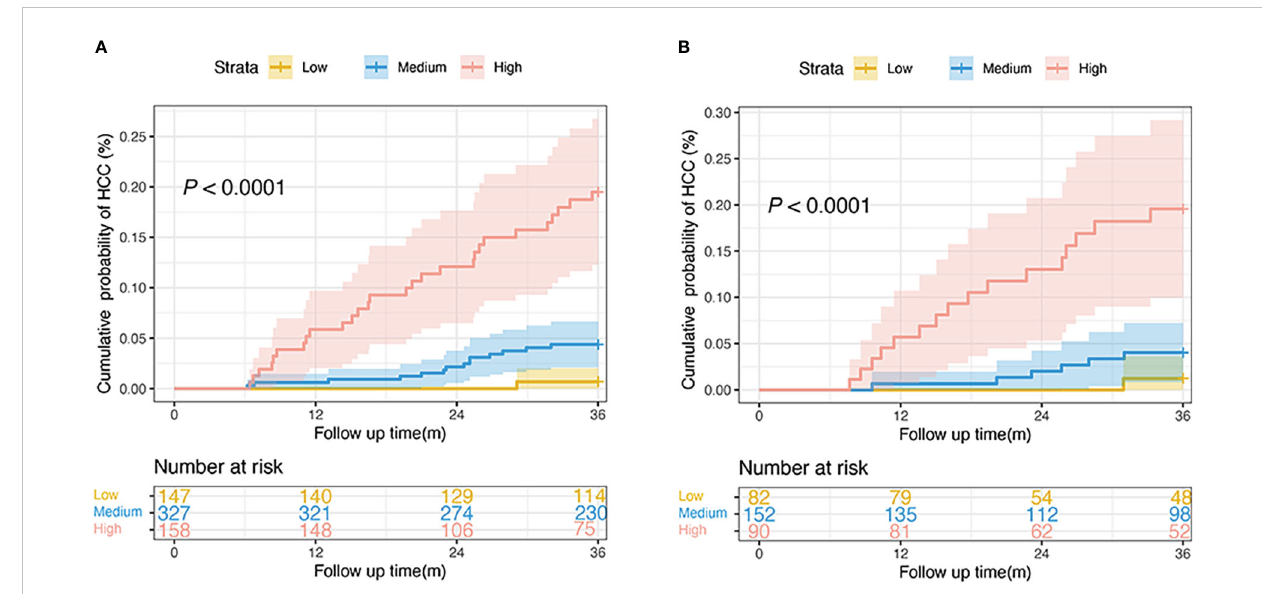
FIGURE 5 Risk strati fi cation of HCC development according to the nomogram scores in the derivation (A) and the validation cohorts (B) . (low-risk, score: < 4; intermediate-risk, score: 4 – 10; high-risk: > 10; P < 0.0001 by log-rank test). HCC, hepatocellular